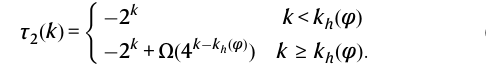
Fig. 3 | Chaotic vs Uncomputable RG fl ow behaviour. In both diagrams, k represents the number of RG iterations and η represents some parameter char- acterisingtheHamiltonian;theblueandreddotsare fi xedpointscorrespondingto different phases. We see that in the chaotic case ( a ), the Hamiltonians diverge